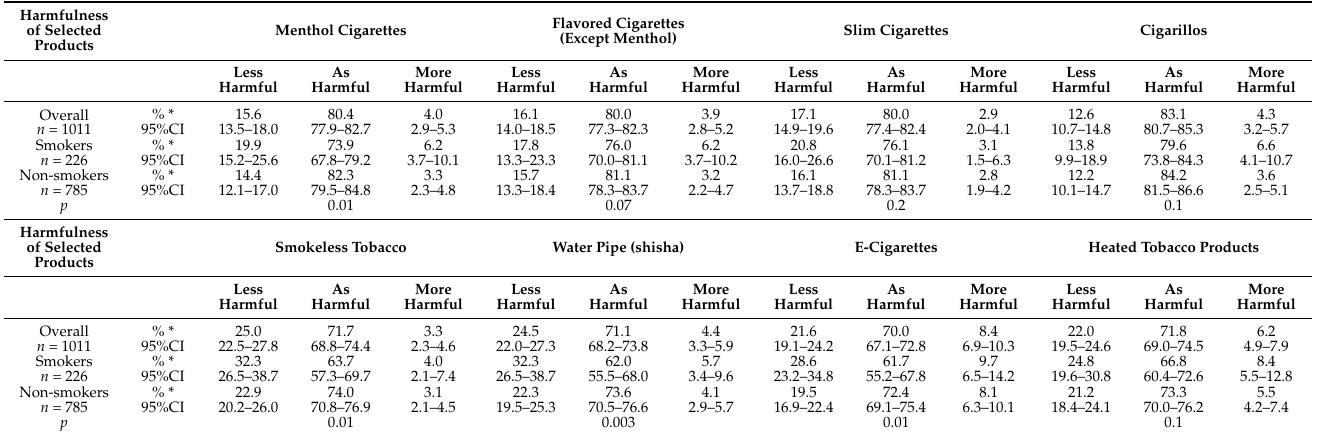
Table 2. Harm perceptions of various tobacco products and e-cigarettes by smoking status ( n = 1011). Harmfulness ofSelected